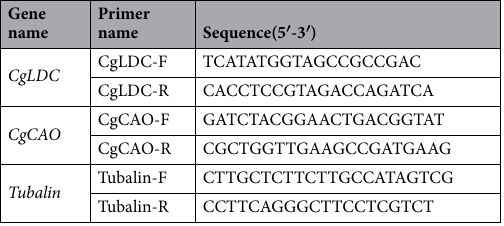
Table 1. Primers used for